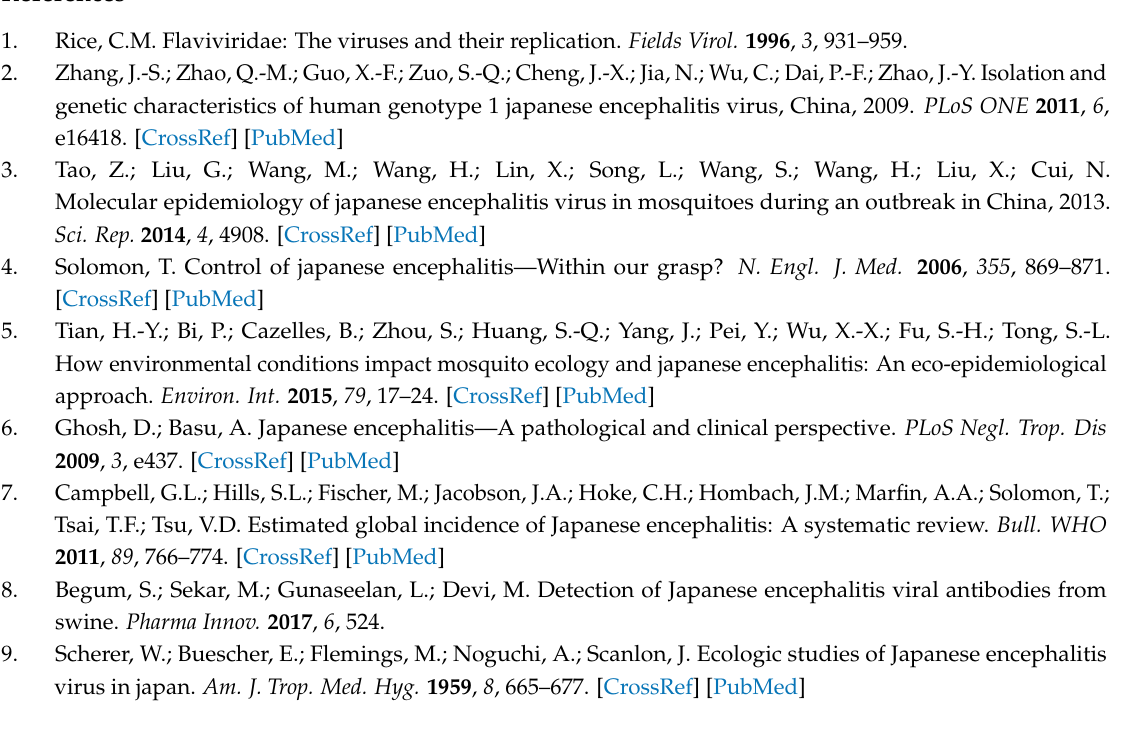
s1, Table S1: Literature Sources. Literature sources of mosquito collections, Table S2: Model predictions of reported human JE cases, Supplementary File S1: Binary models representing suitable/unsuitable areas. Author Contributions: B.L. and H.W. carried out the experimental design. B.L. and X.G. carried out geo-database and model building, and data analysis. X.G., J.M., Z.J., and J.X. helped in data collection and data